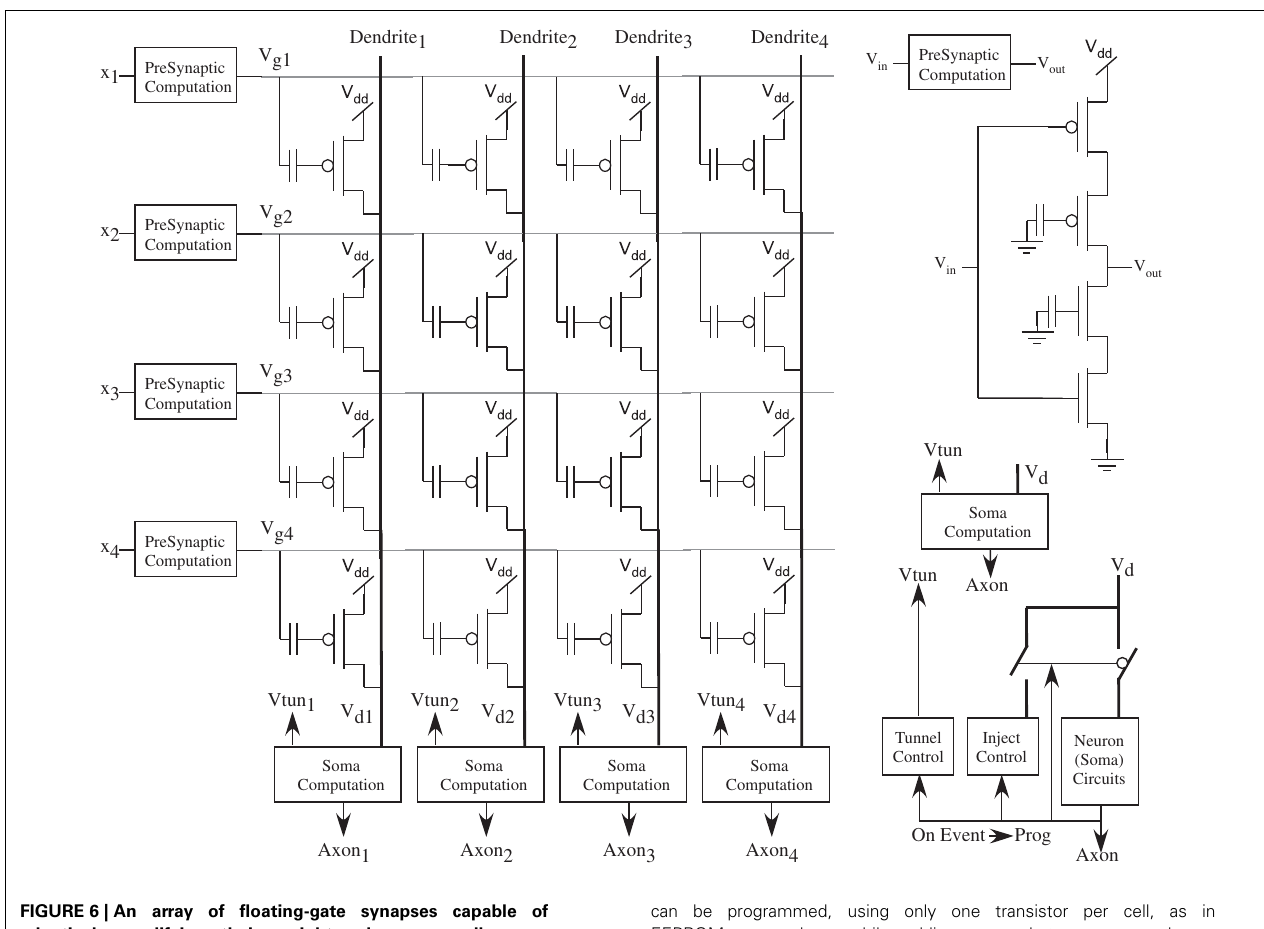
can be programmed, using only one transistor per cell, as in EEPROM approaches, while adding somewhat more complex circuitry on the